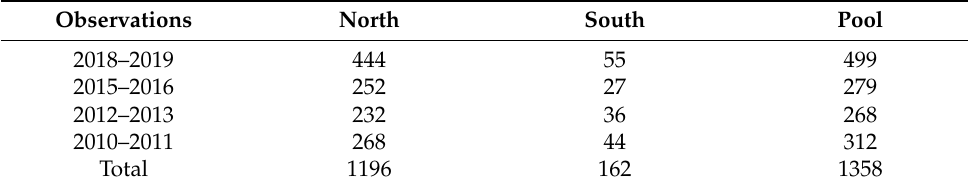
Table 1. Number of observations by